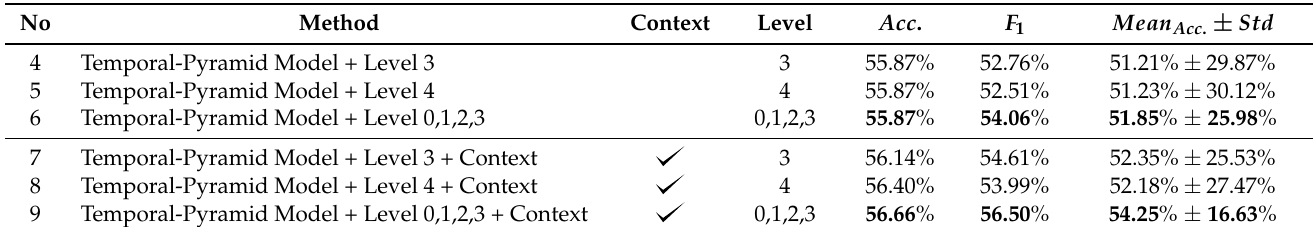
Table 4. Performance results of the temporal-pyramid models on the AFEW validation set.